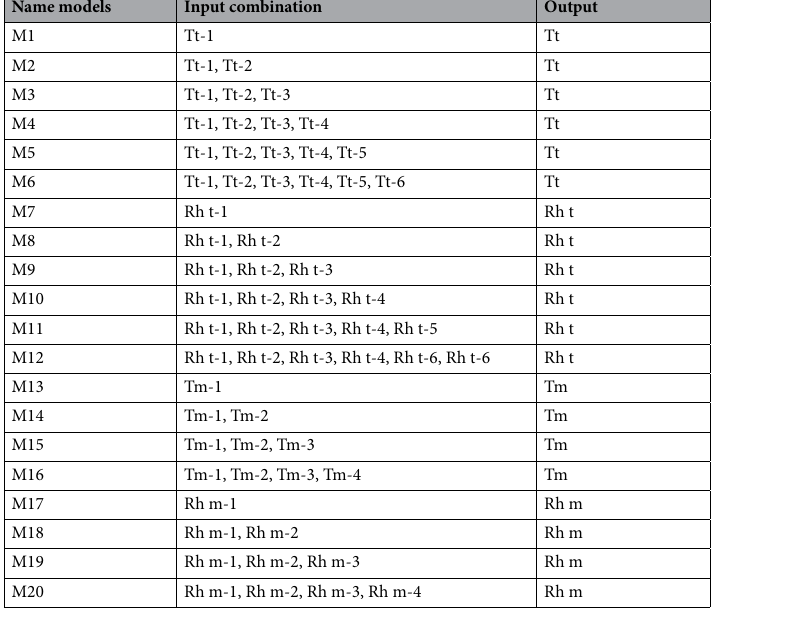
Table 2. Input design for air temperature and relative